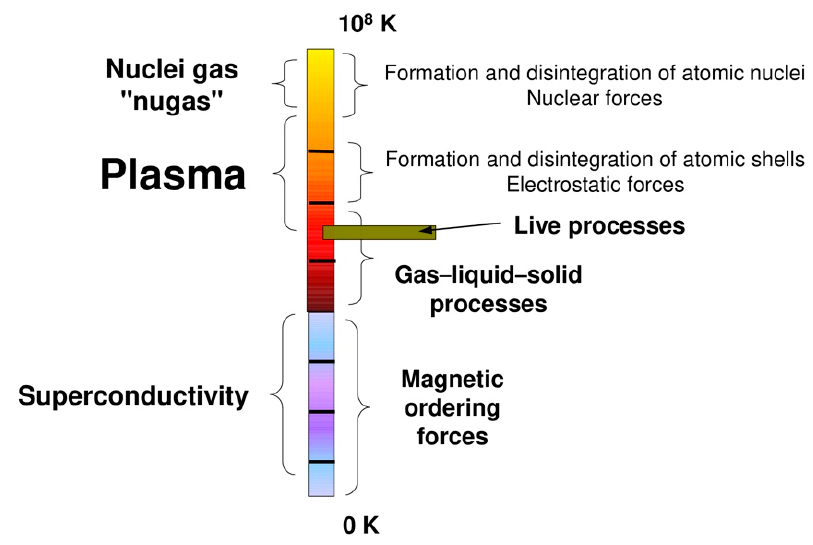
Figure 2. Thermodynamic scale of temperatures with marked phenomena of plasma and supercon ‐ ductivity.